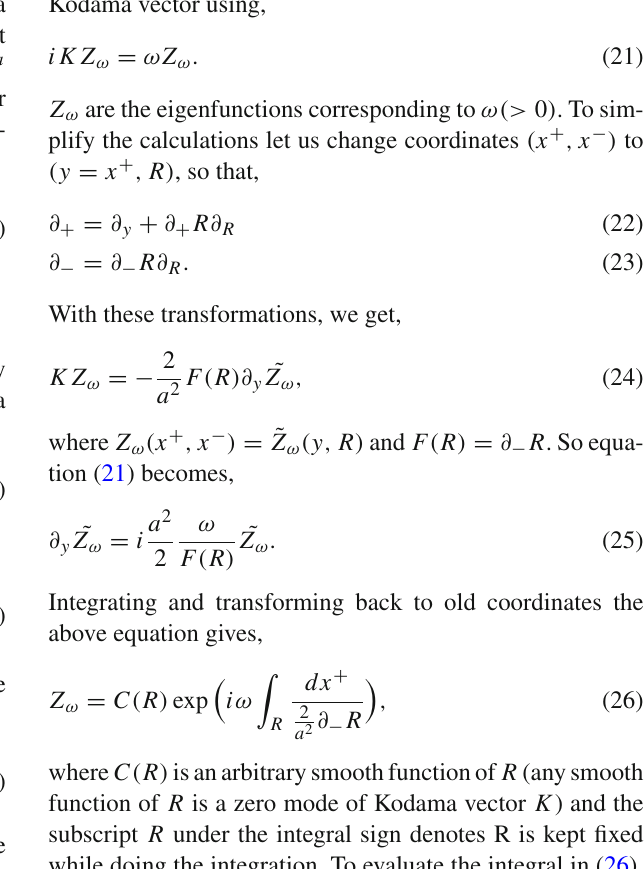
Fig. 1 Penrose diagrams for flat ( k = 0 ) FLRW spacetimes with a = t q , and p = wρ , where q = 2 : a timelike 3 ( 1 + w) apparent horizon with w = 0, b null apparent horizon with w = 1 / 3, c spacelike apparent horizon with w = 2 /